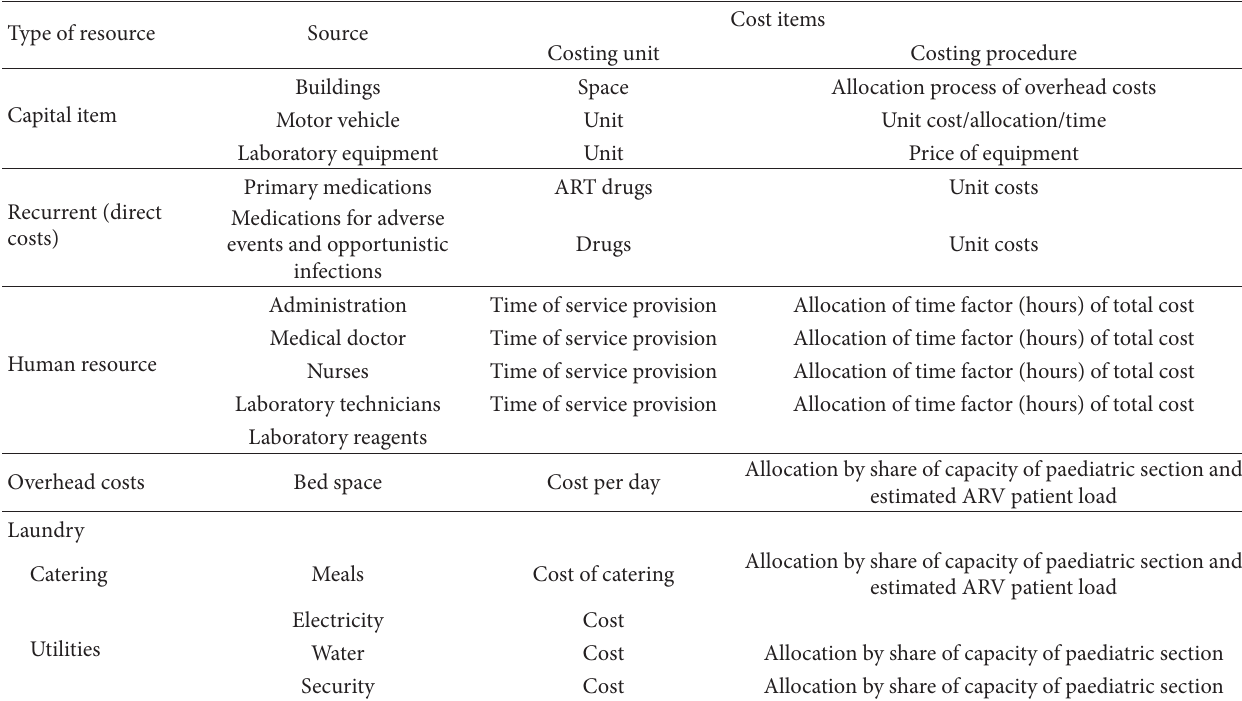
Table 2: Sources of resource